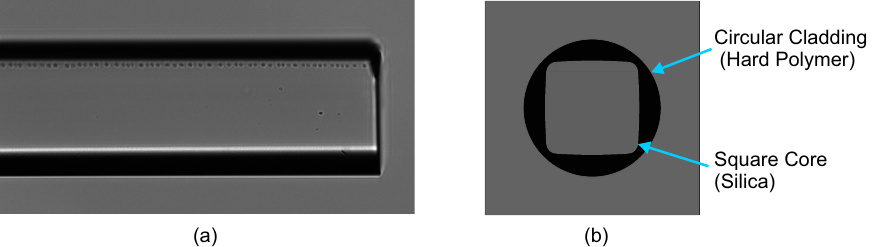
Figure 2. ( a ) Photo of square-core fiber from the top view. ( b ) Schematic diagram of the square core